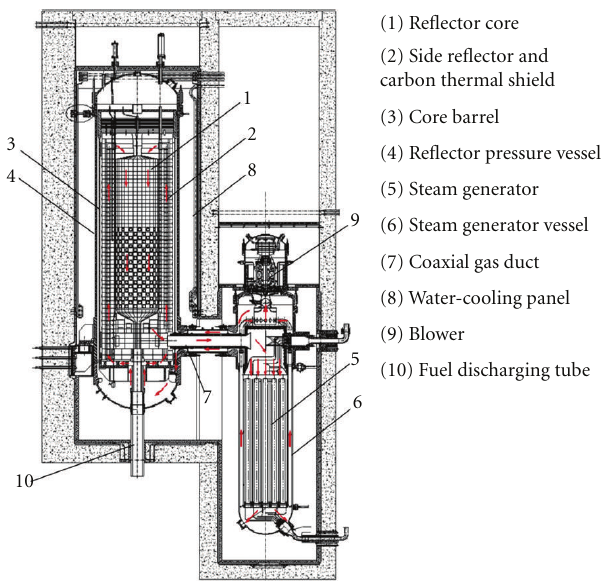
Figure 1: Primary loop of